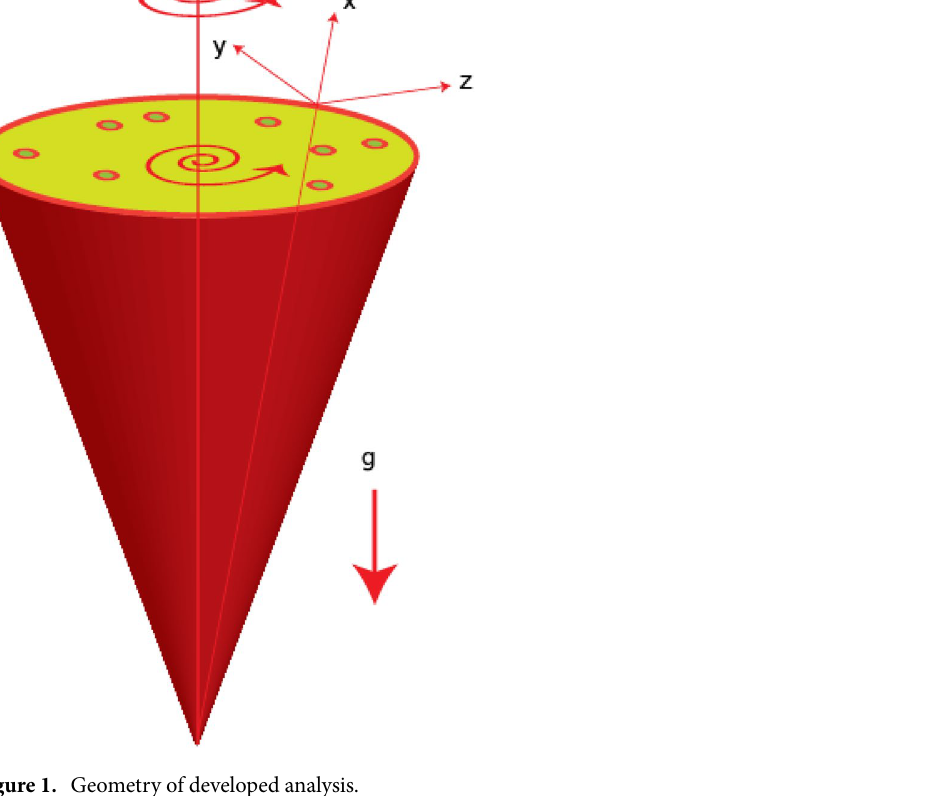
Figure 1. Geometry of developed